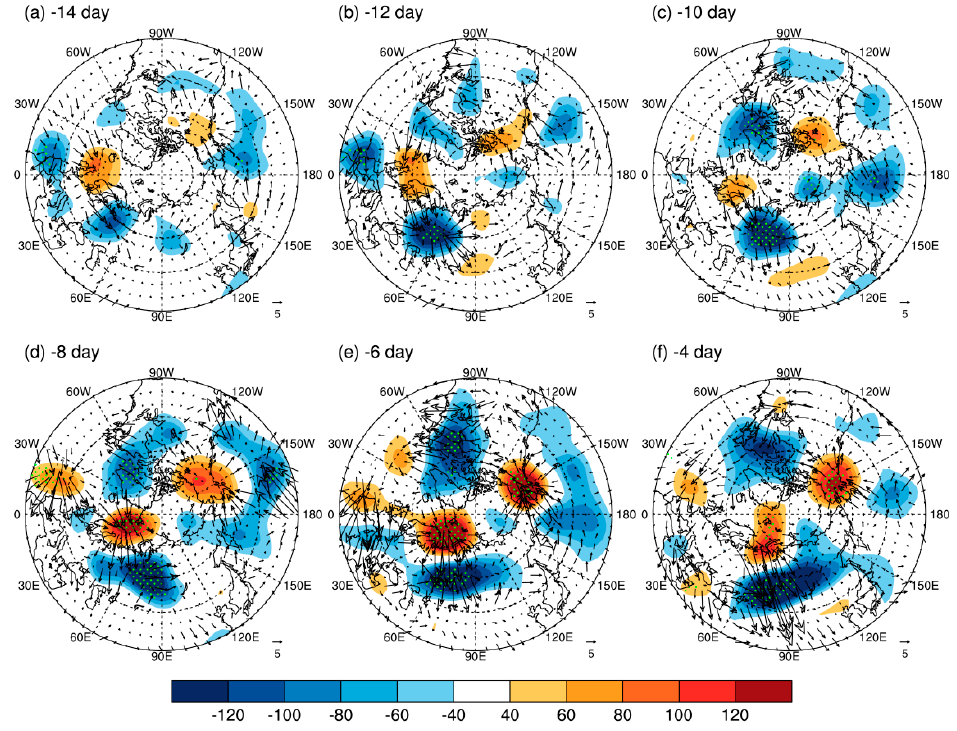
Figure 11. Same as Figure 9, but for the west type ( a–f ).